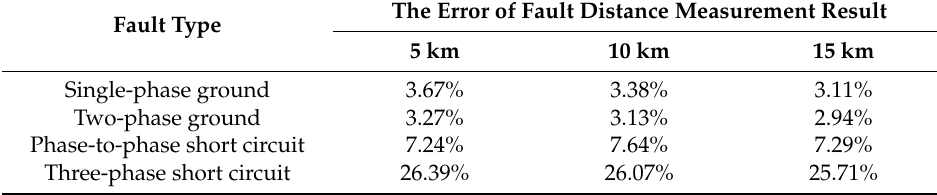
Table 2. Performance of the Fourier method when faults